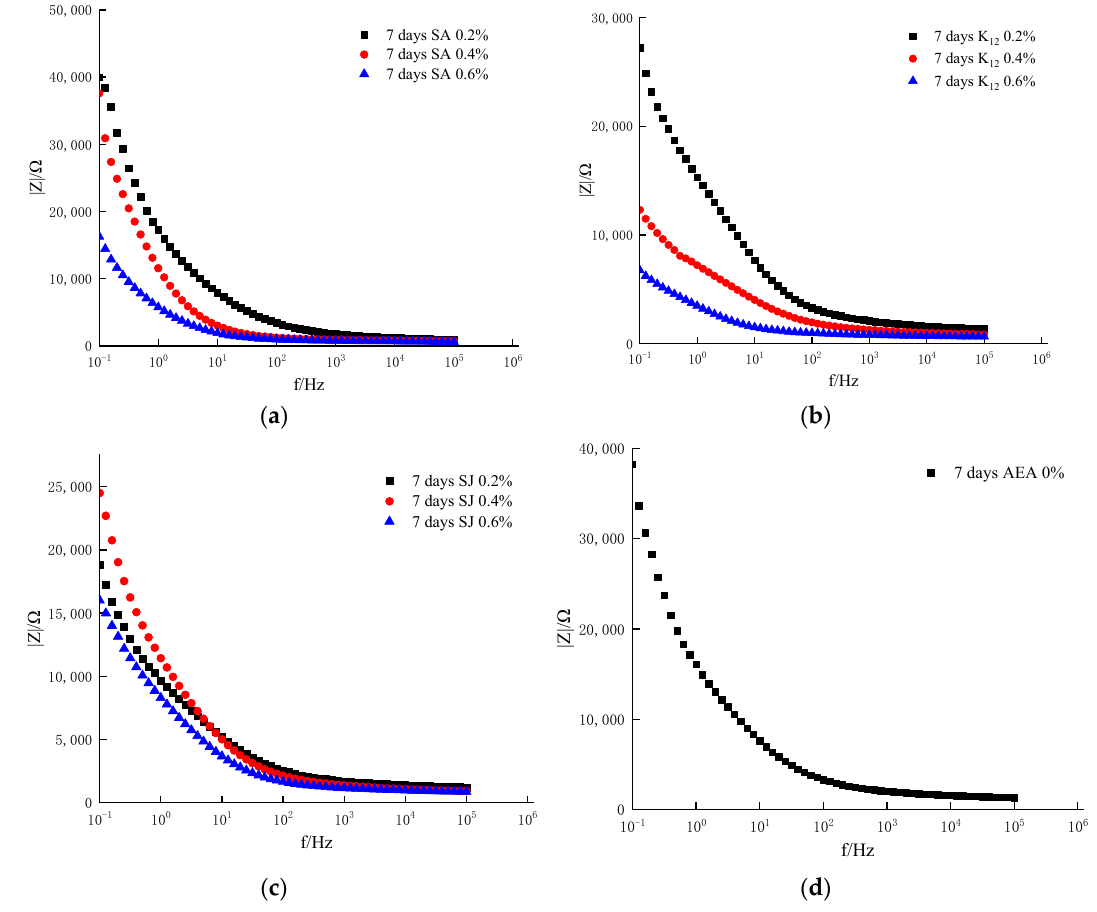
Figure 4. Relationship between AC impedance value and frequency of filling test block with different AEA added for 7 days of curing age. ( a ) Add SA; ( b ) Add K 12 ; ( c ) Add SJ; ( d ) 0% AEA.